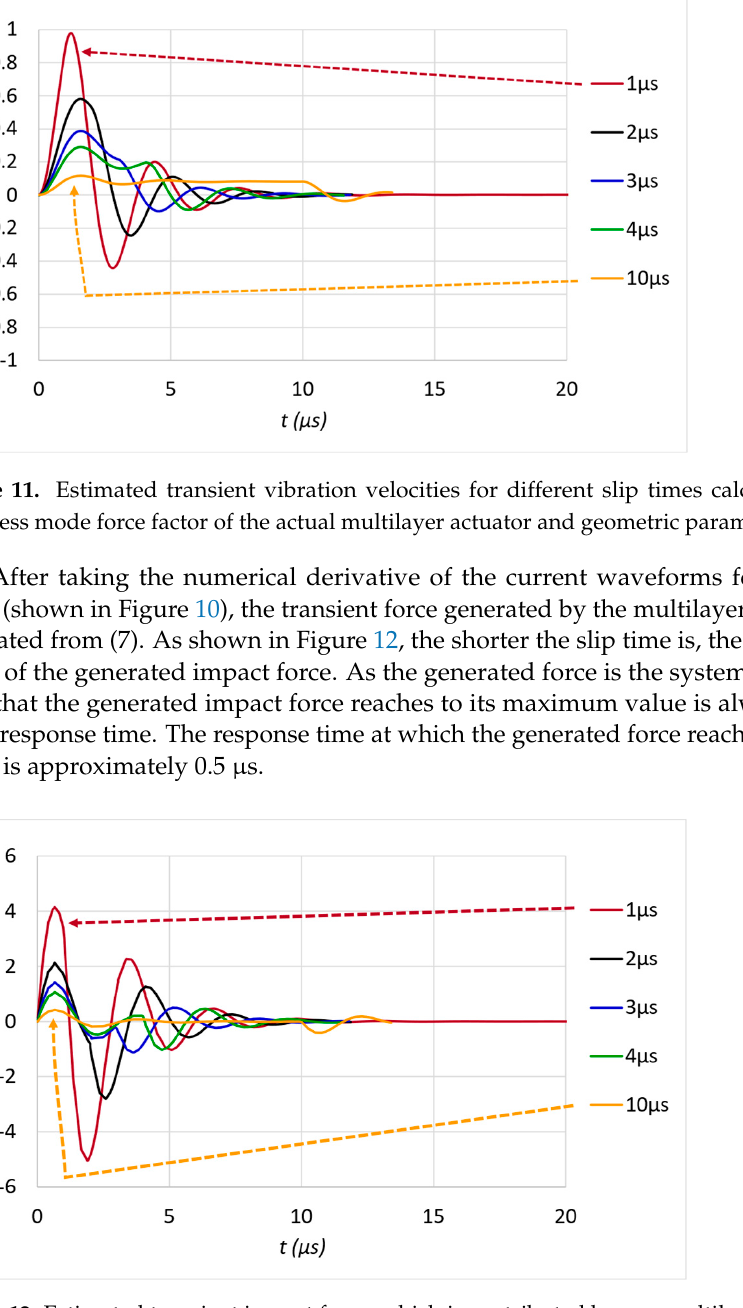
Figure 12. Estimated transient impact force, which is contributed by one multilayer actuator in the stator.